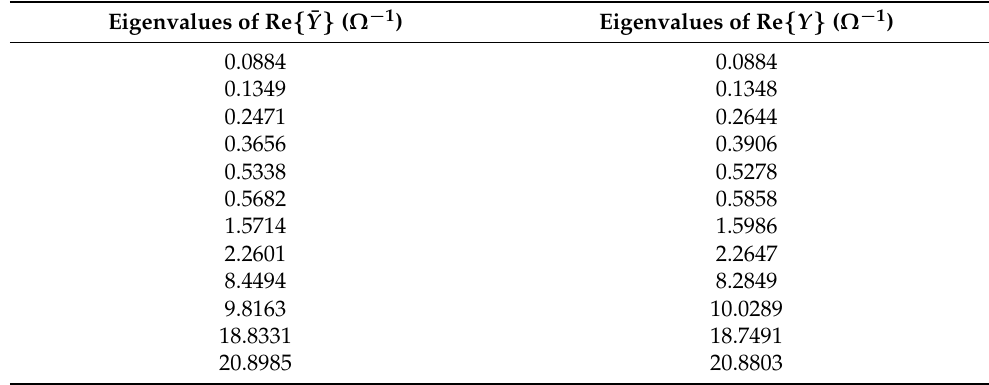
Figure 10. Results of a numerical experiment with n = 6. Table 4. Eigenvalues of the estimated conductance matrix Re { Y } compared to the eigenvalues of the actual conductance matrix Re { ¯ Y } in the case n =